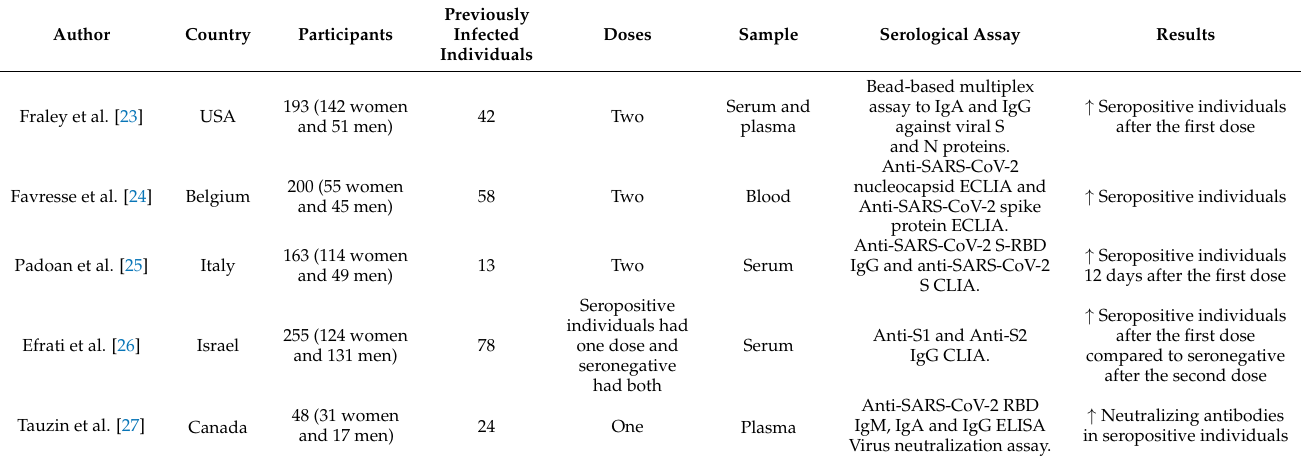
Table 1. Antibody response induced by the application of the BNT162b2 vaccine in previously infected